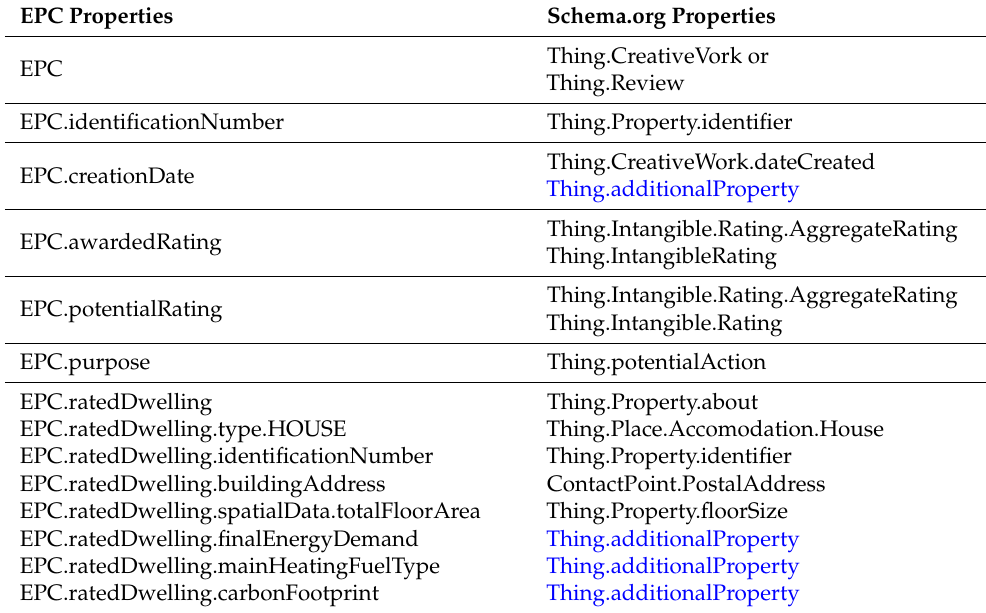
Table 9. EPC properties as schema.org